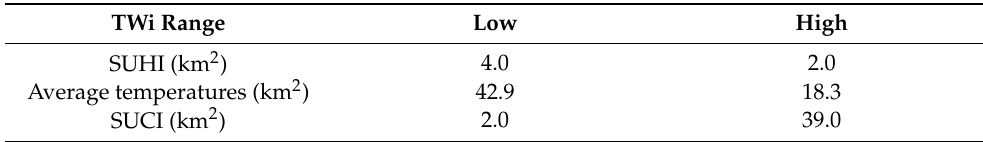
Figure 7. Average surface heat islands and socioeconomic distribution in the city of Arica. Table 3. Distribution of surface temperatures by socioeconomic range.